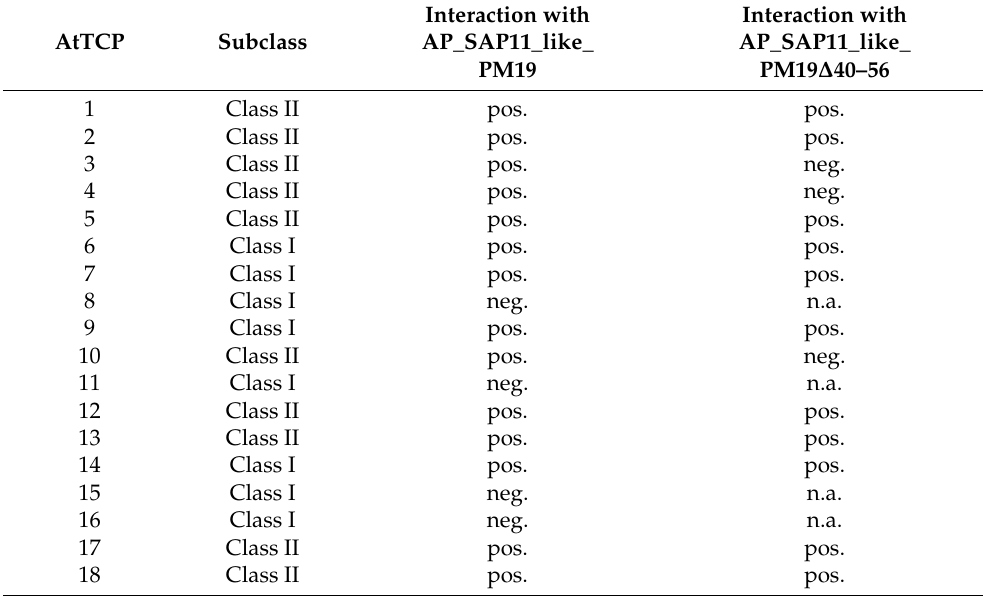
Figure 6. Example for Y2H results of AP_SAP11-like_PM19 and AP_SAP11-like_PM19 ∆ 40–56 with different AtTCPs. Y2H screens were performed using the binding domain fused to AP_SAP11- like_PM19 (BD-SAP11-like) or AP_SAP11-like_PM19 ∆ 40–56 (BD-SAP11-like- ∆ 40–56) and the ac- tivation domain (AD) fused to different AtTCPs. For the negative control, only BD was used. Co-transformed yeast cells were patched on double drop-out medium (DDO) to select for presence of both expression plasmids and DDO media containing Aureobasidin A and X- α -Gal (DDOXA) to select for protein interaction. n.a. = not applicable. A figure showing all Y2H results can be found in the Supplementary Materials (Figure S1). Table 1. Y2H results of AP_SAP11-like_PM19 and AP_SAP11-like_PM19 ∆ 40–56 with different